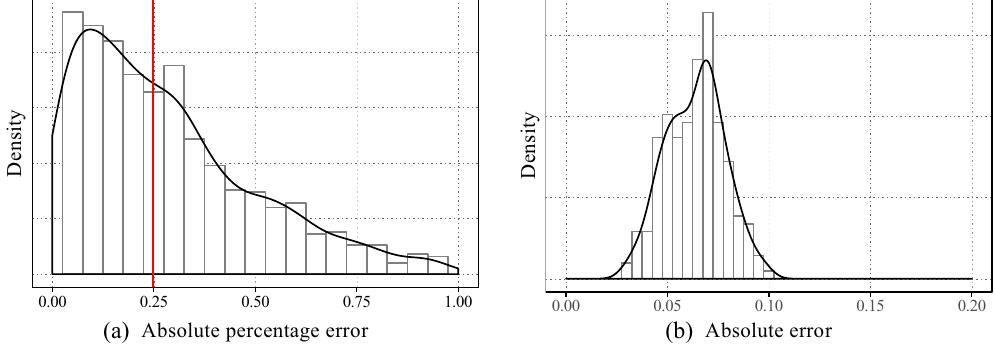
Figure 10. ( a ) Distribution of the absolute percentage errors of the prediction of number of saturated retweets. ( b ) The distribution of prediction error for parameter b by support vector regression.